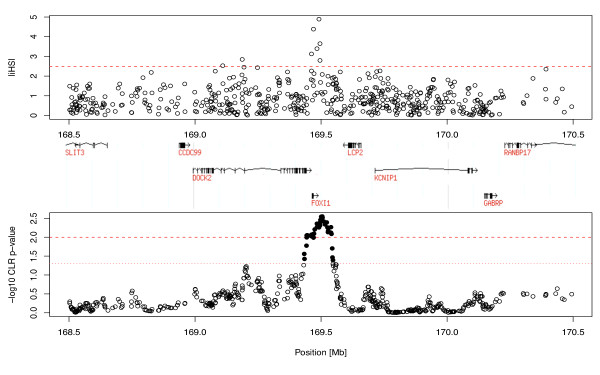
iHS values against physical distance in the Sub-Saharan African continental sample. iHS values for individual SNPs flanking the FOXI1 region (2 Mb) against physical distance (top panel) and p-values for the composite likelihood ratio (CLR) test based on a 31-SNP sliding window analysis to detect local regions enriched for high iHS values (bottom panel). Solid circles above the dotted line indicate P-values below 0.05 genome-wide significance level, and the dashed line indicates the P = 0.01 threshold.